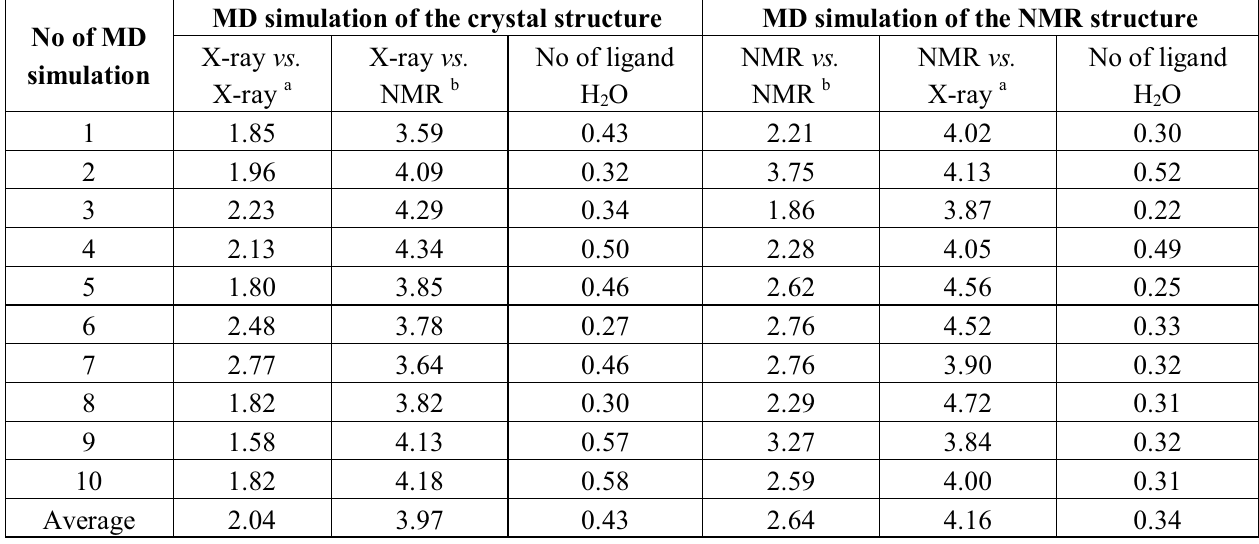
Table 2. RMSD of main-chain atoms in Å unit after 20-ns MD